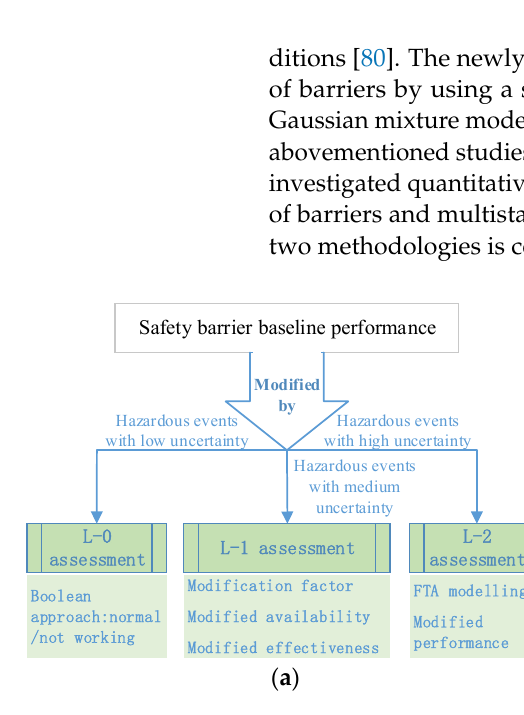
Figure 13. Methodologies to assess the performance degradation of safety barriers. ( a ) With reference to [21]. ( b ) With reference to [74].